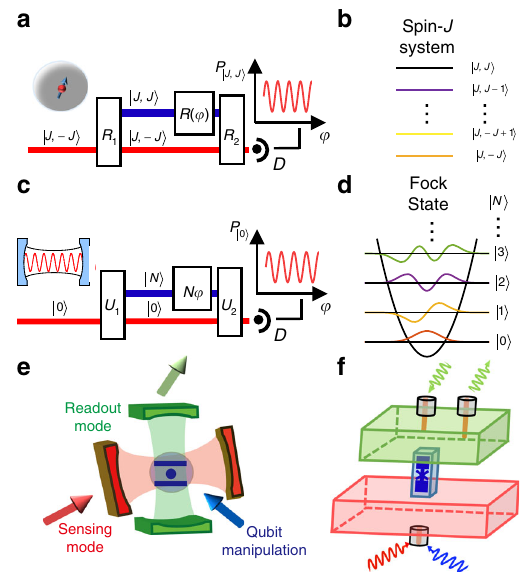
Fig. 1 Single-mode quantum metrology architectures. a , b Single-atom Ramsey interferometer with a total angular momentum number J . The best precision can be achieved by using the superposition of | J , − J 〉 and | J , J 〉 with the maximum variance of angular momentum. c , d Single-mode Ramsey interferometer for photons/bosons with an optimal precision achieved by the superposition of Fock states with the maximal variance of photon numbers for a given mean photon number. e , f Schematic illustrations of the single-mode sensing architecture and the experimental circuit quantum electrodynamics system. A single qubit couples to two photonic cavity modes, with the two modes serving as the sensing mode and the ancillary qubit readout mode, respectively. The two boxes represent the microwave cavities, between which the ancillary superconducting qubit on a chip is located in a waveguide